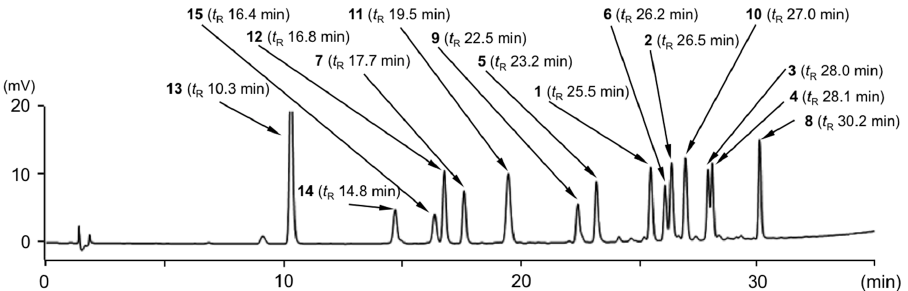
Figure 2. Typical HPLC chromatogram (UV, 284 nm) of standard solution mixture (each 25 µg/mL).